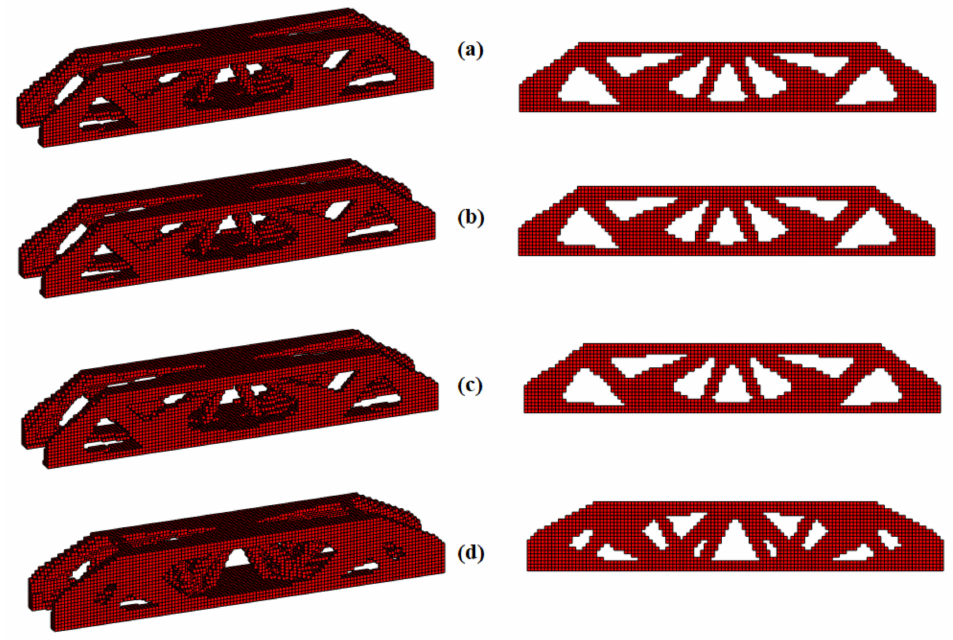
Figure 9. Optimal topology (DTO)—side view and front view: ( a ) ESO, ( b ) SERA, ( c ) SESO and ( d )